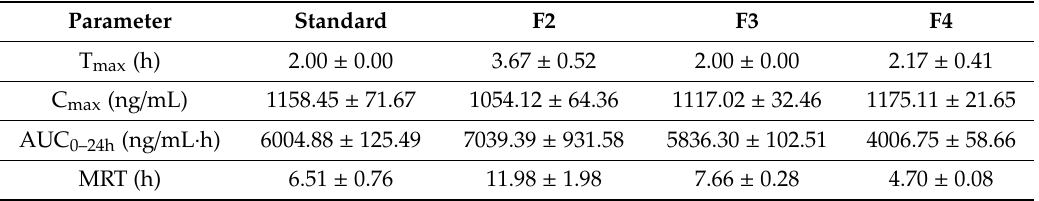
Table 4. Pharmacokinetic parameters of 3D printed captopril tablets (n =